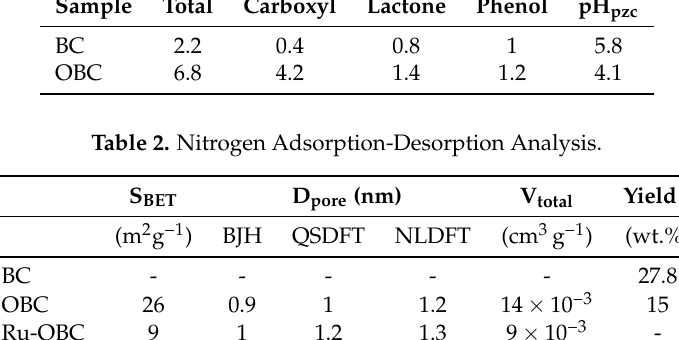
Table 1. Boehm’s Concentration of Oxygenated Functionalities (mmolg −1